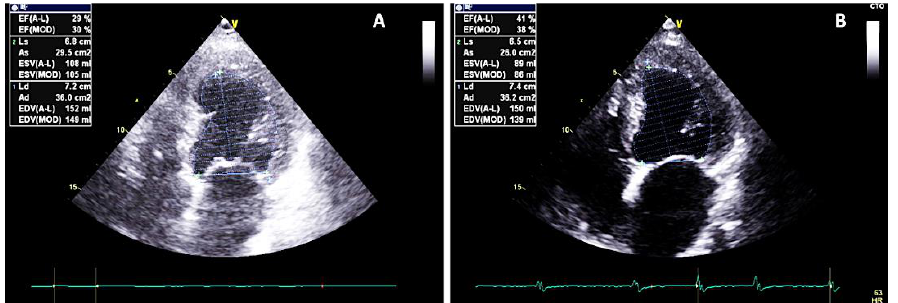
Figure 4. The four chambers viewed at baseline ( A ) and at 18-month follow-up ( B ). Note the reverse remodelling of the left ventricle with an increase in systolic function of the left ventricle (LVEF 41% using the Simpson biplane method).